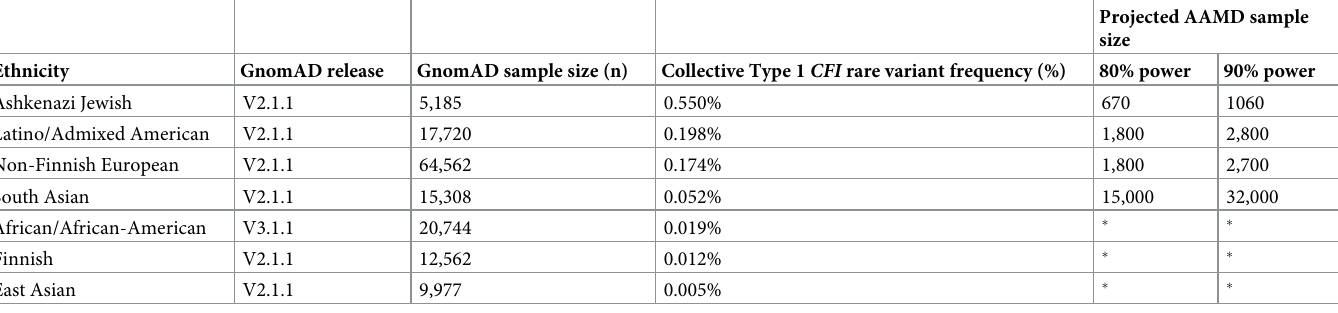
Table 2. Projected AAMD sample sizes required to test for significant association between Type 1 CFI rare variants and disease in different ethnicities defined by